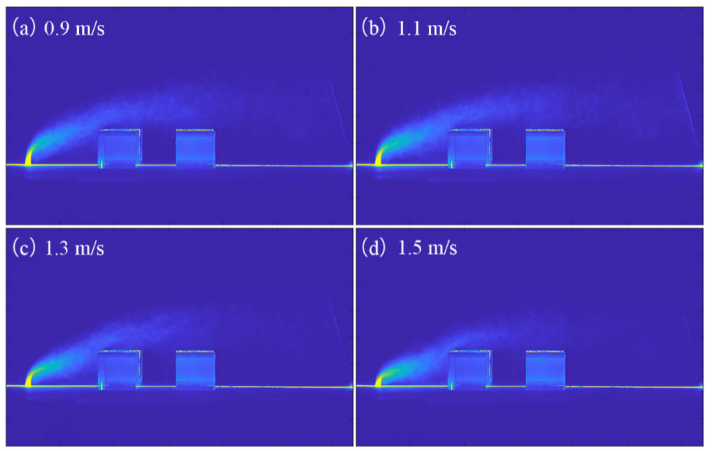
Figure 22. Time-averaged concentration fields on the vertical plane (y = 0) of a typical ideal street with different characteristic wind speeds: ( a ) u 0 = 0.9 m/s; ( b ) u 0 = 1.1 m/s; ( c ) u 0 = 1.3 m/s; ( d ) u 0 = 1.5